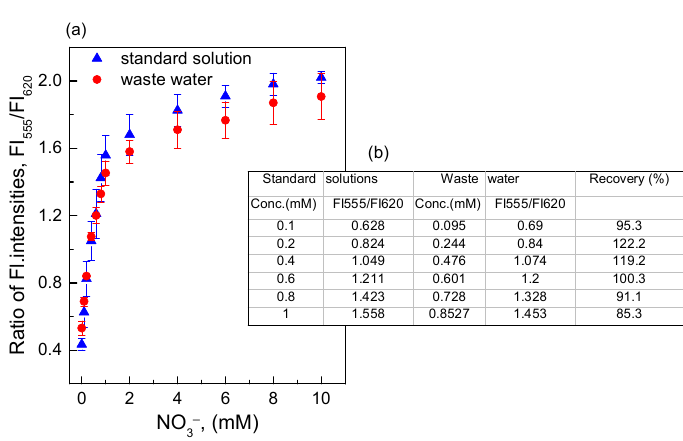
Figure 8. ( a ) Response of the O17-HT-EC membrane to different nitrate concentrations in standard solutions and artificial waste water; ( b ) Table for the recovery of the O17-HT-EC membrane when exposed to different nitrate concentrations in artificial waste water. Table 1. Summary of certain nitrate